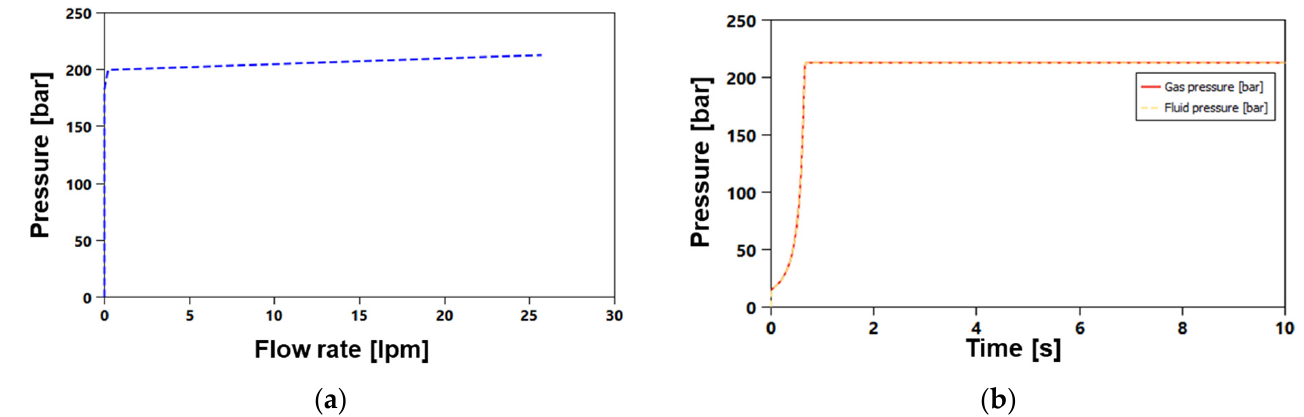
Figure 3. The hydraulic component design for the partial PST tractor. ( a ) Relief valve, ( b ) accumulator.